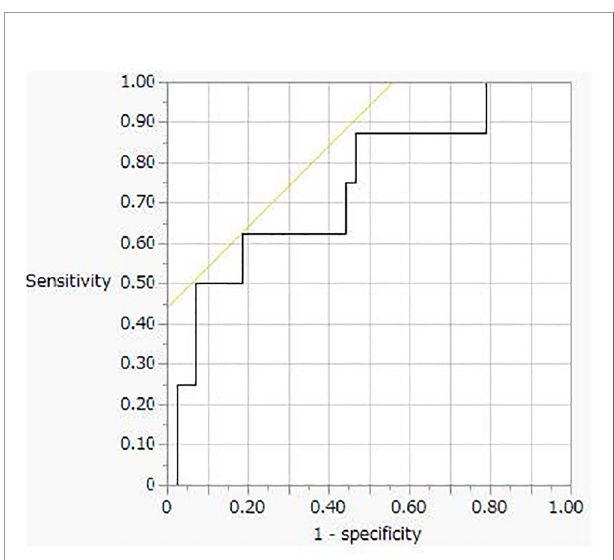
FIGURE 3 | The receiver operating characteristic (ROC) curve analysis for oral sodium loading test cut off value.